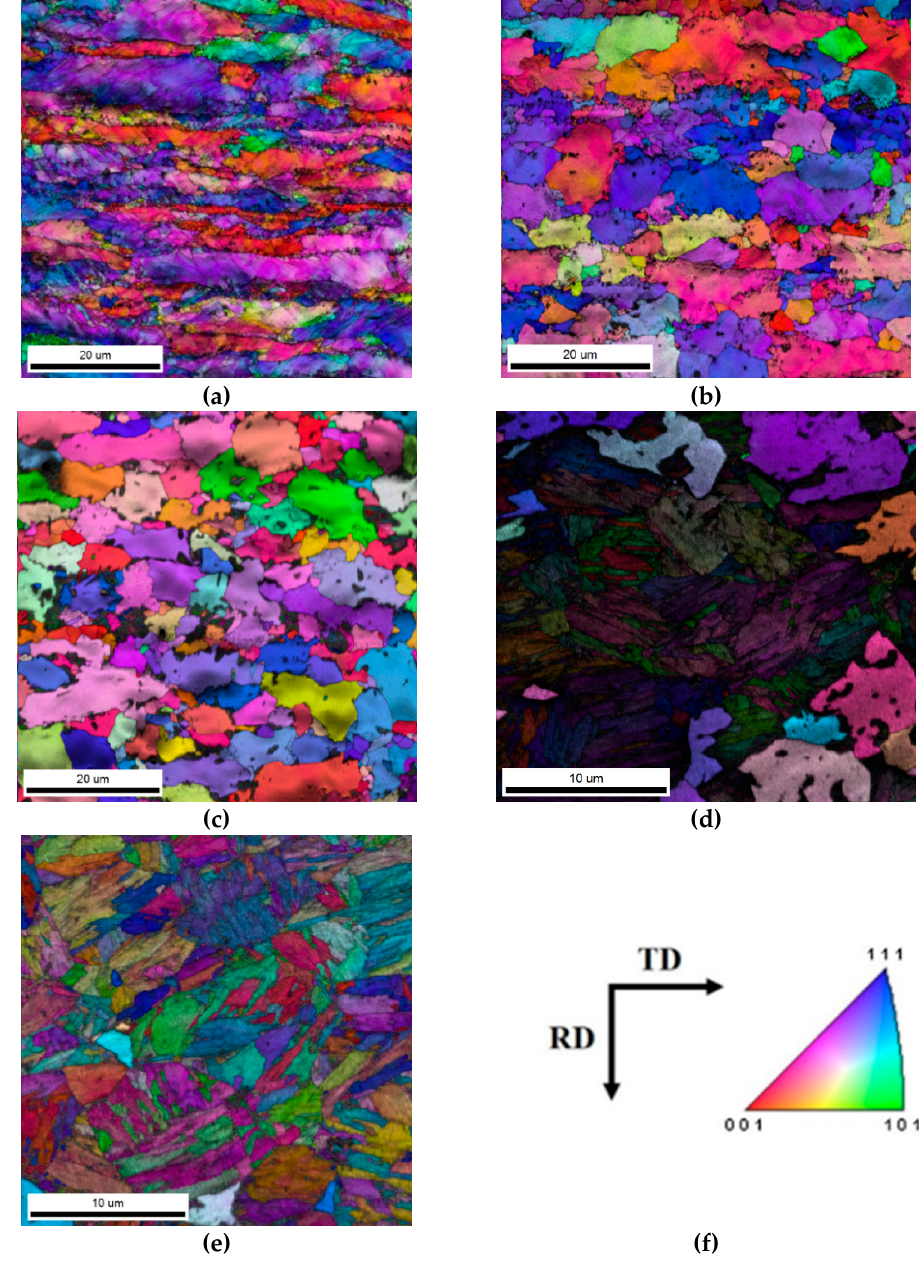
Figure 12. IPF + IQ diagram of a hot-stamped part with tailored properties with different deformation ratios after a tensile test; ( a ) ε = 0.607; ( b ) ε = 0.04; ( c ) ε = 0.0064; ( d ) ε = 0.0048; ( e ) ε = 0.0039; ( f ) different colors represent different orientations: blue represents the orientation of {111}; red represents the orientation of {001}; green represents the orientation of {101}.